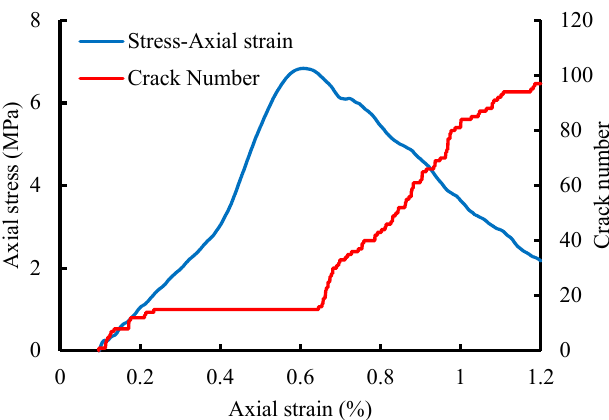
Figure 10. Axial stress-axial strain curve.